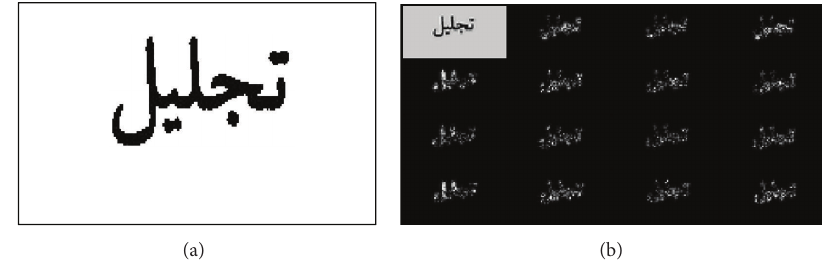
Figure 5: A wavelet packet decomposition: (a) the original image, (b) wavelet packet decomposition subbands in level